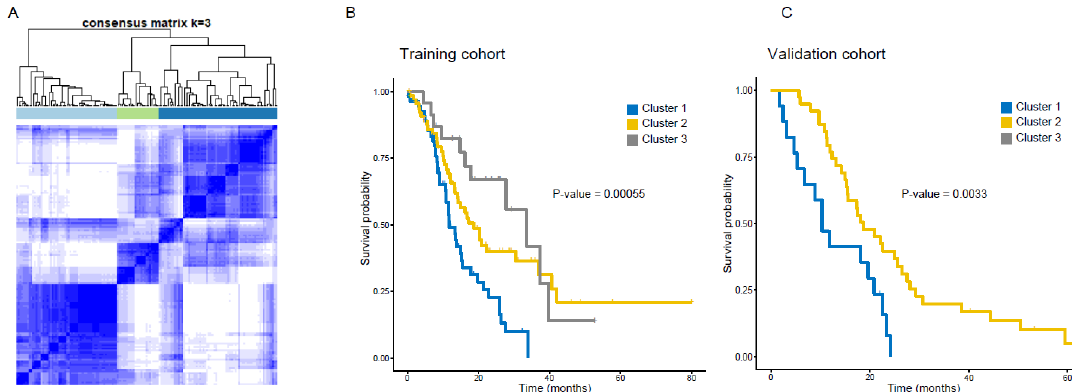
Figure 2. Clustering analysis of GBM patient using radiomics; consensus clustering of GBM tumors with prognostically relevant radiomics features revealed three distinct radiomics subtypes which differed in survival outcome. ( A ) A consensus matrix derived from consensus clustering; each cell of the matrix refers the proportion of clustering runs where two instances are clustered together, ranged between 0 (white) and 1 (blue).1 implies perfect consensus among the entire resampling runs; ( B ) survival plots of GBM patients classified by radiomics subtypes (training cohort); ( C ) survival plots of GBM patients classified by radiomics subtypes (validation cohort).